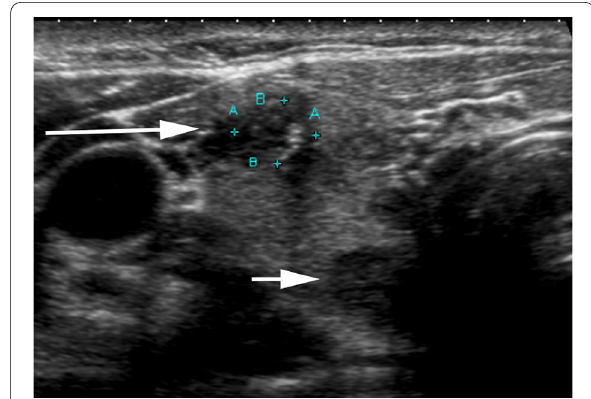
Fig. 1 52-Year-old female with multi-nodular goiter and 6 mm PTC in upper pole of right lobe of gland (long arrow). The PTC nodule is hypoechoic with irregular margins and microcalcification. An adjacent similar sized hypoechoic benign nodule with well-defined margins (short arrow) is seen in the posterior aspect of upper pole of right lobe of thyroid gland. It is important to meticulously document the location of the PTC (in this instance as right, upper, anterior) to prevent mistaking an adjacent benign nodule for the PTC at